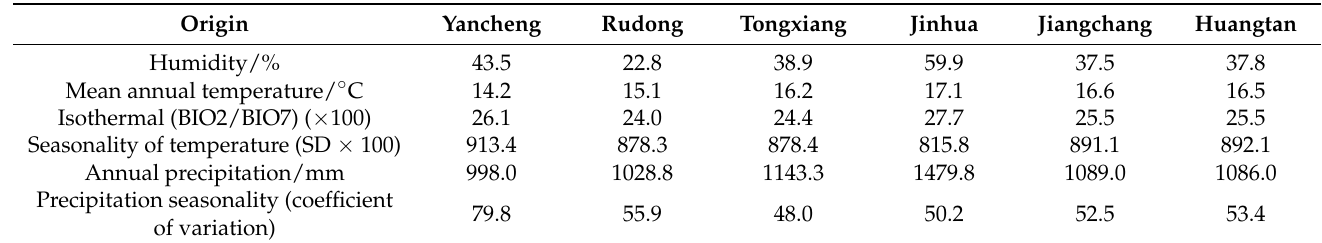
Table 2. Average information table of climate factors from different